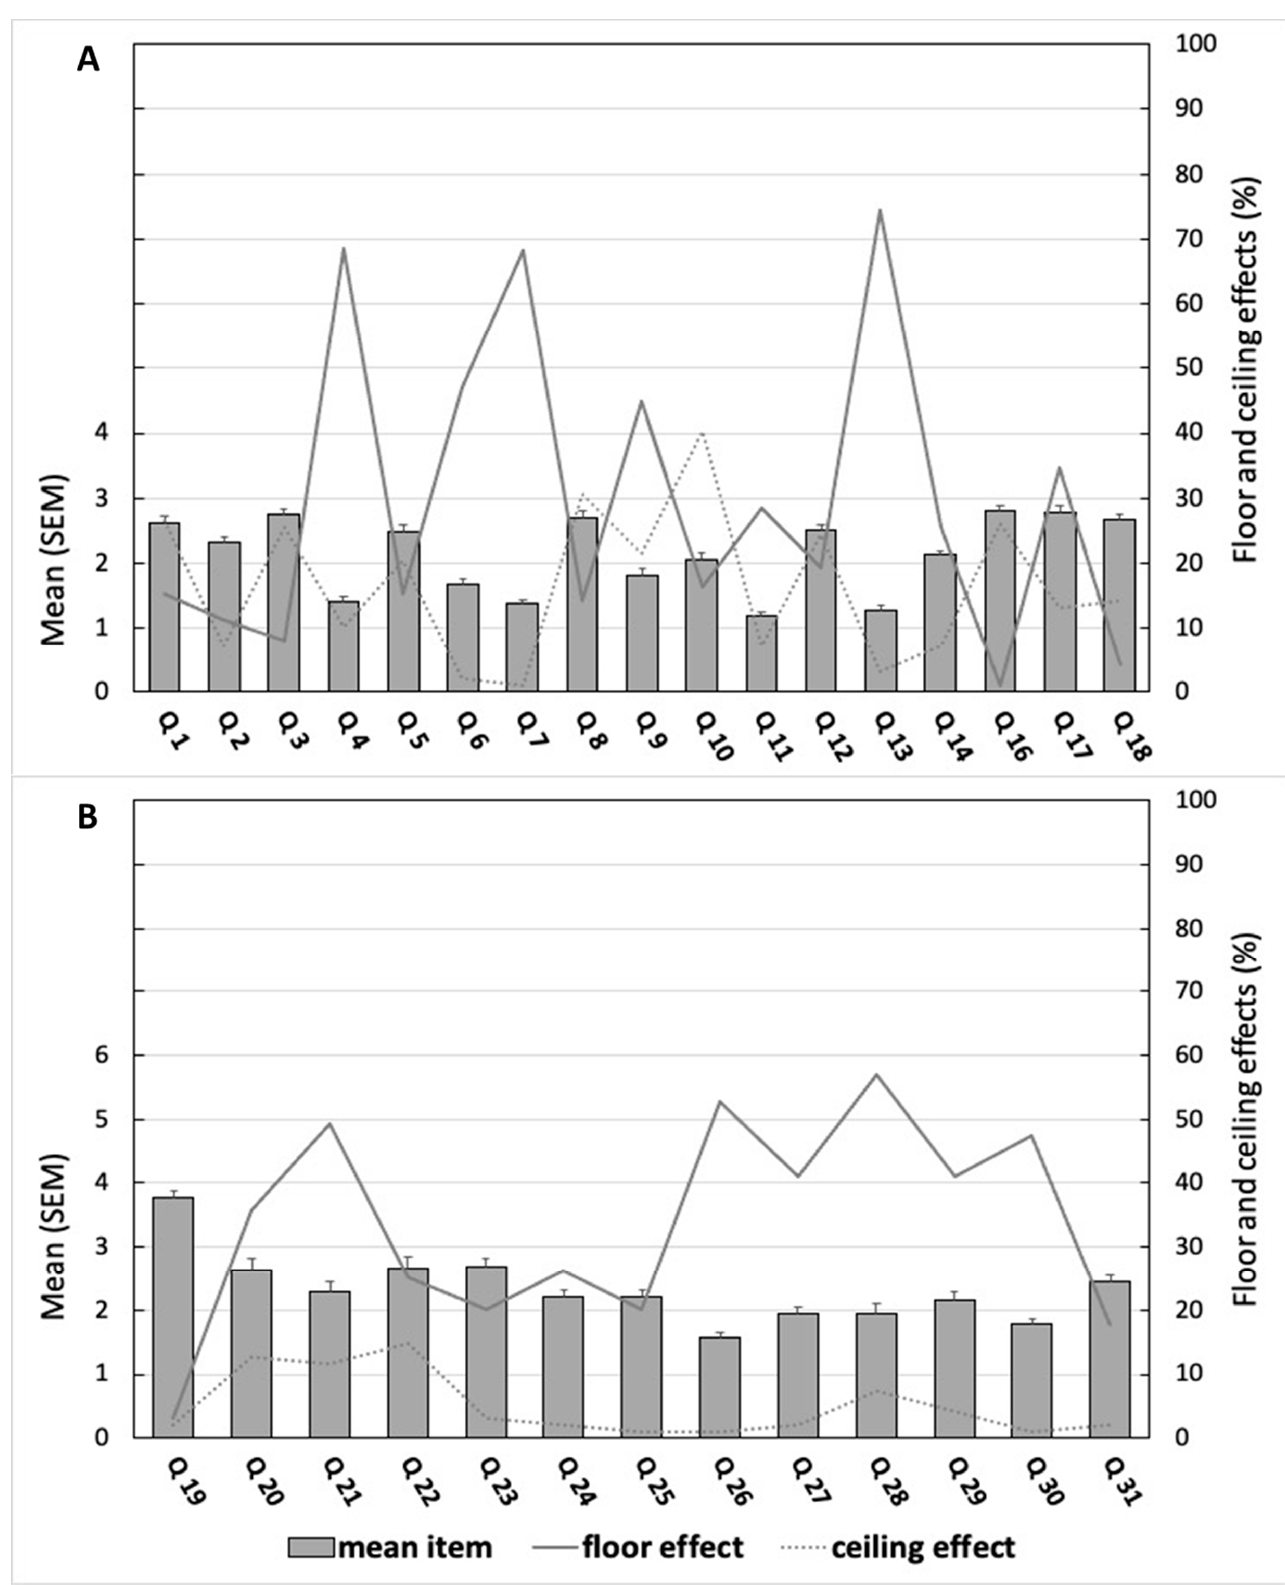
Figure 1. Acceptability of the CAPAS-Q for the overall sample (mean item ± SEM, floor and ceiling effects) for PA evaluation ( A ) and SB evaluation ( B ) dimensions.